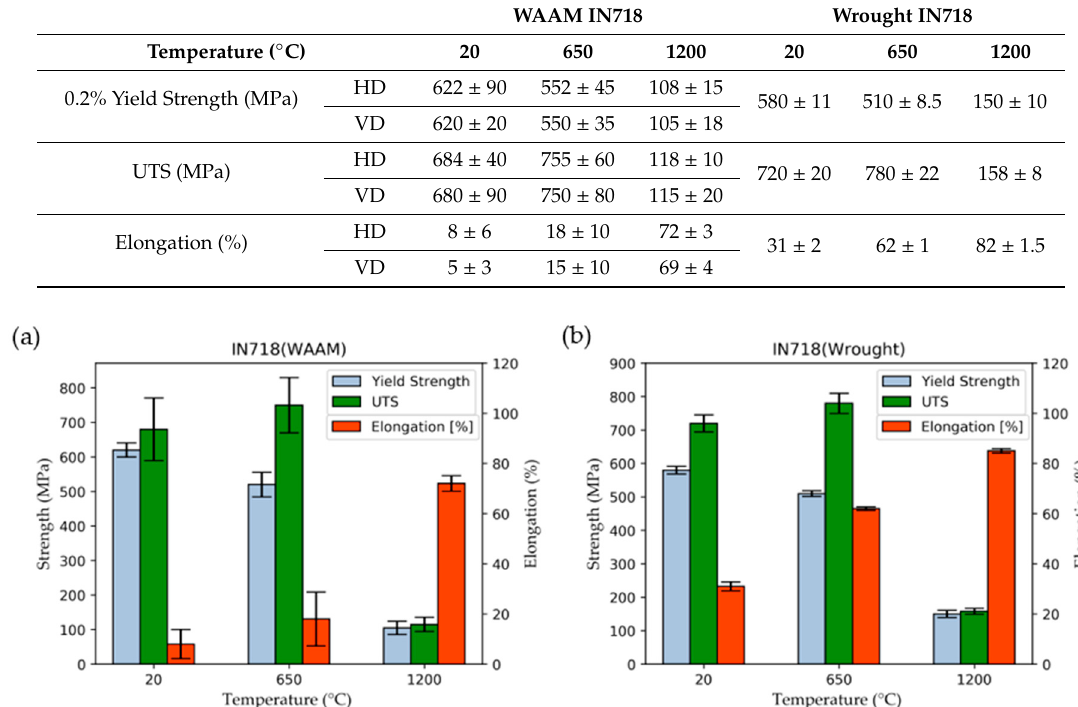
Table 2. Statistical analysis on tensile results of WAAM and Wrought IN718 alloy.